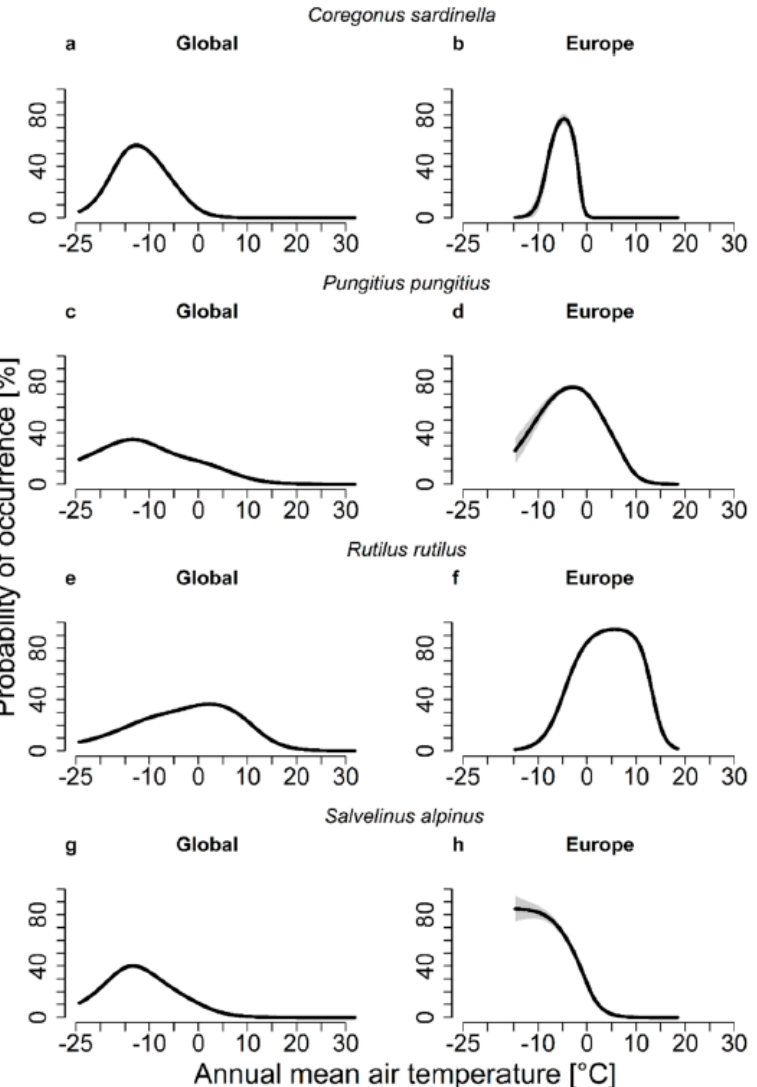
Figure 1. Thermal response curves along the annual mean air temperature gradient. Thermal response curves are displayed for ( a , b ) C. sardinella , ( c , d ) P. pungitius , ( e , f ) R. rutilus , and ( g , h ) S. alpinus at the global and European scale, respectively. The grey area around the response curves represents the 95% confidence interval. Table 1. Comparison between the thermal characteristics inferred from global and European species distributions.